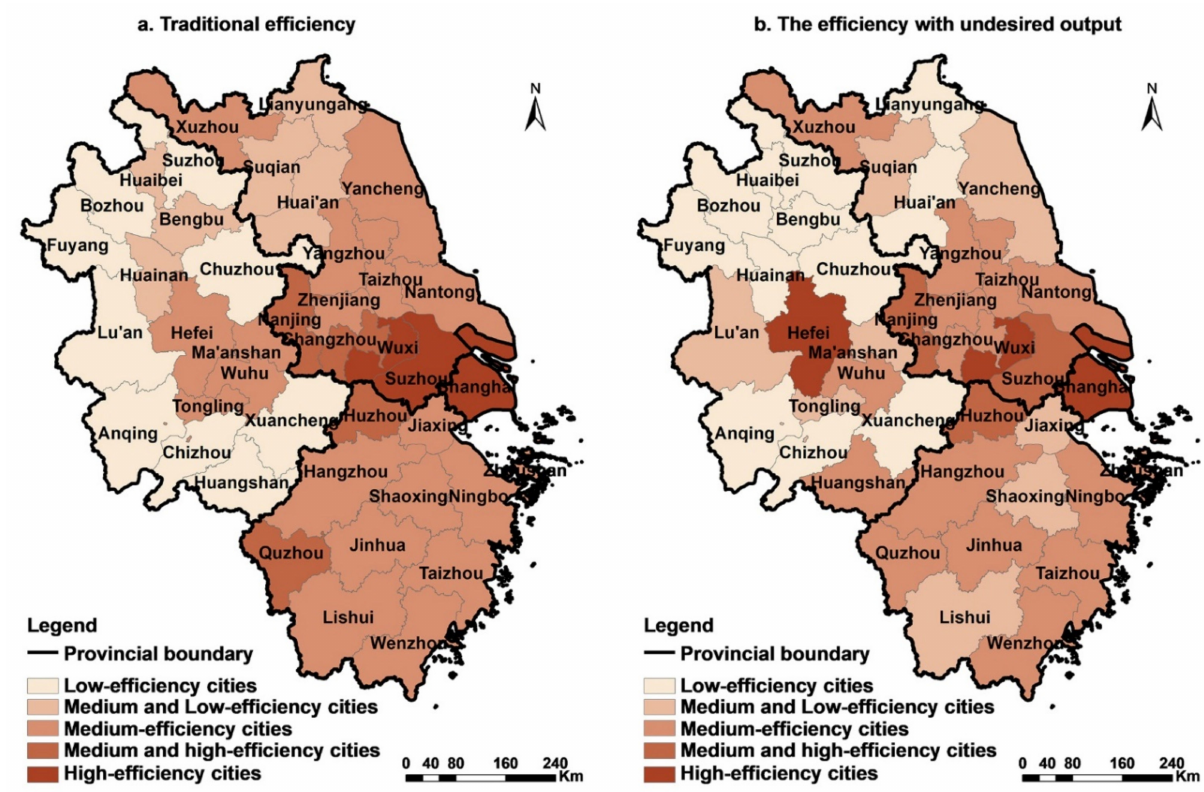
Figure 4. Mean value comparison between the traditional efficiency of urban construction land and the efficiency with unde- sired outputs in the Yangtze River Delta from 2009 to 2017. ( a ) Traditional efficiency; ( b ) efficiency with undesired